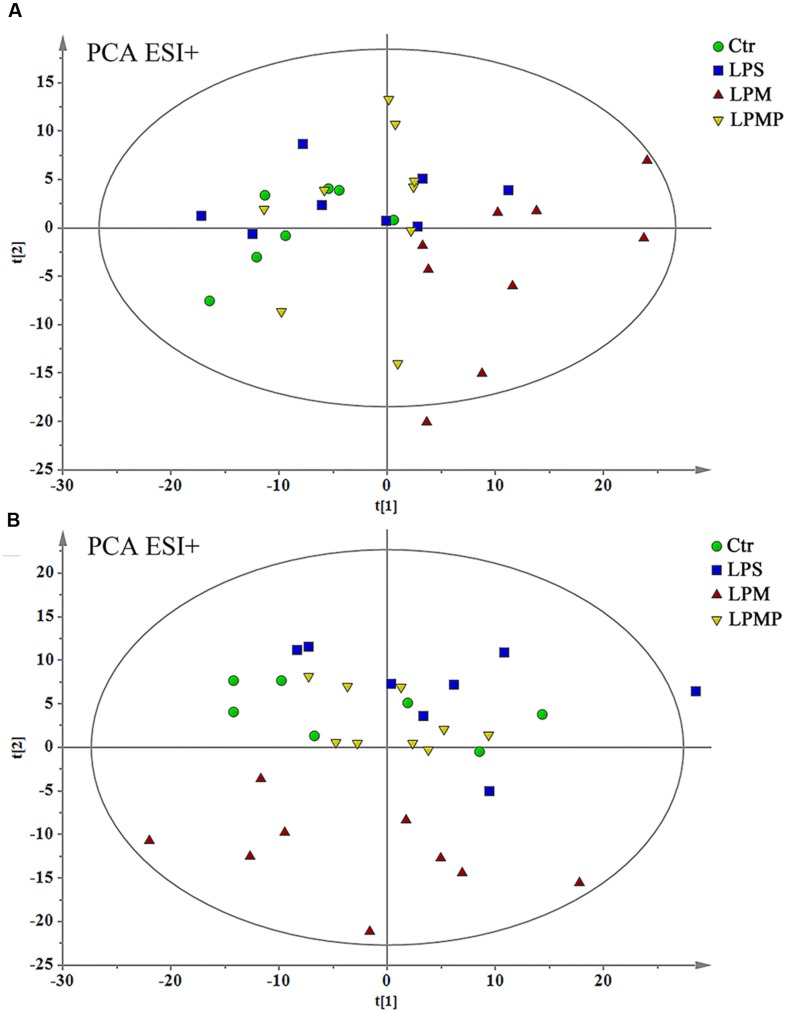
Principal component analysis scores plot of comparing Ctr, LPS, LPM, and LPMP groups in positive ESI modes (A) and negative ESI modes (B).